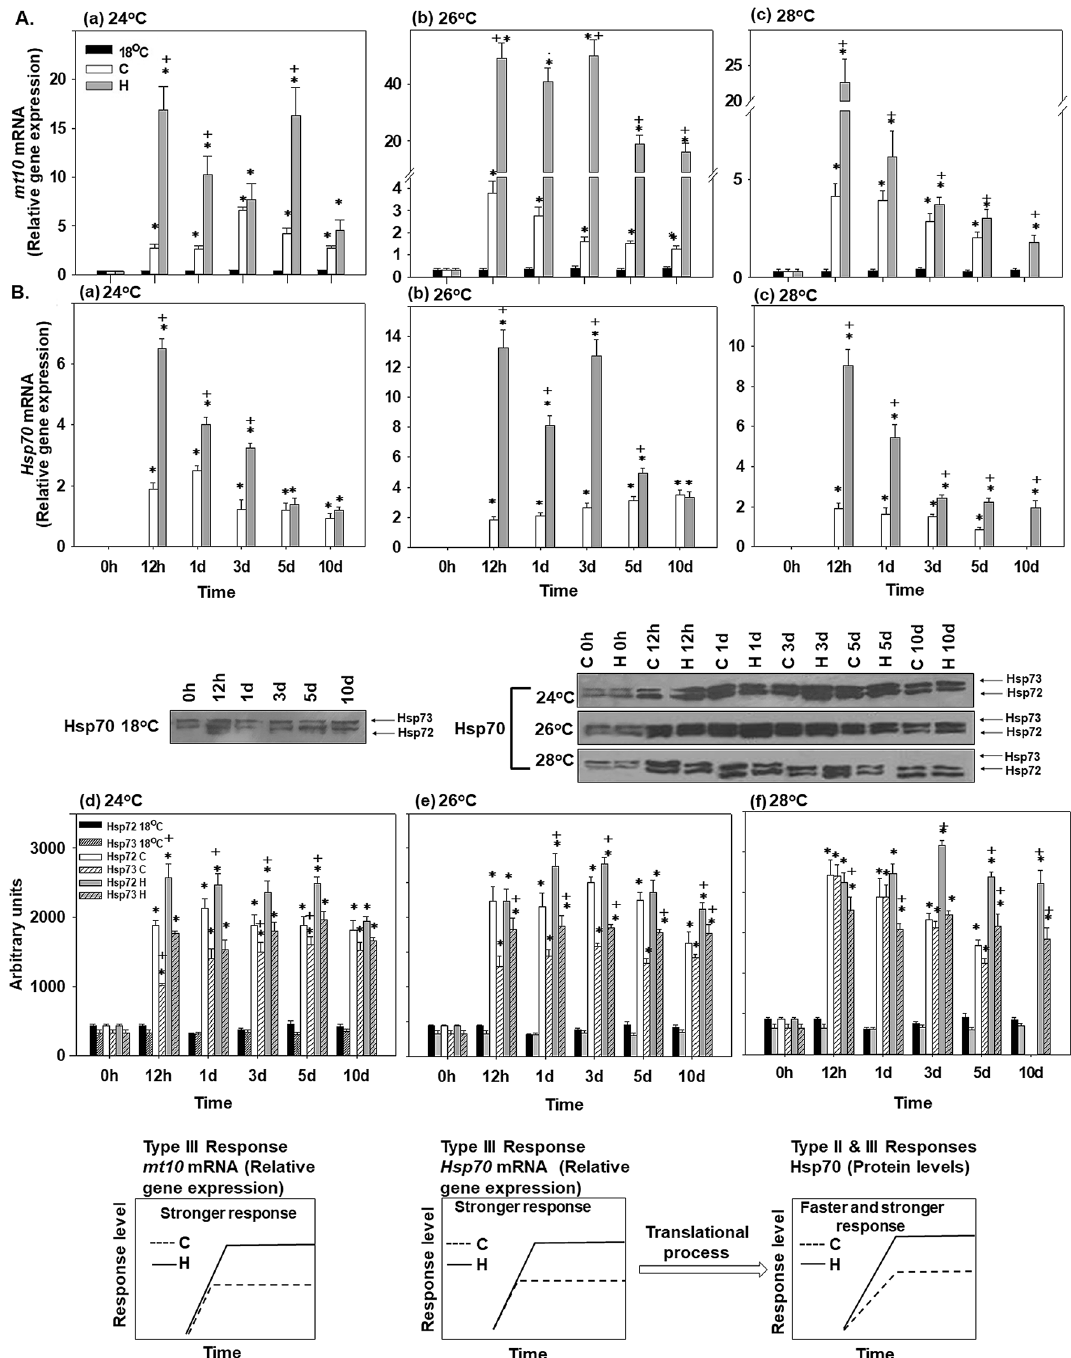
Figure 6. Changes in ( A) the relative metallothionein-10 mRNA levels [Type III (stronger) response] and in ( B ) the relative Hsp70 mRNA levels [Type III (stronger) response], and Hsp72 and 73 levels [Type II & III (faster and stronger) responses] in the mantle of heat hardened (H) and non-hardened (C) Mytilus galloprovincialis when exposed to 24 °C (a,d), 26 °C (b,e) and 28 °C (c,f) compared to control at 18 °C. Representative blots are shown. Blots were quantified using scanning densitometry. Full-length blots/gels are presented in Supplementary Fig. 2. Values are means ± SD, n = 8 preparations from different animals. * p < 0.05 compared to day 0, + p < 0.05 compared to non-hardened (C)